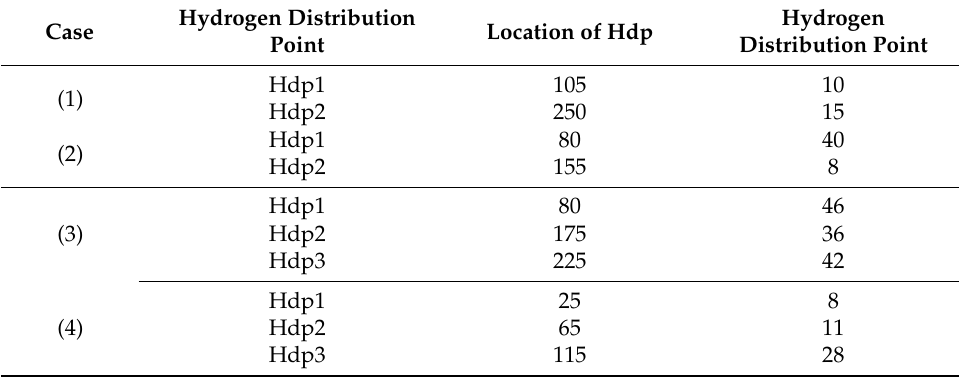
Table 10. Summary of location of hydrogen distribution point